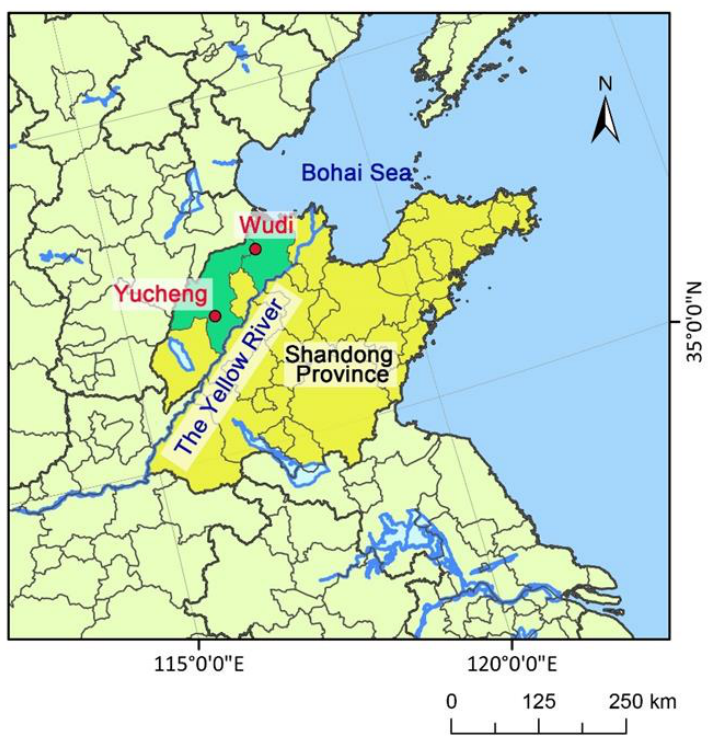
Figure 1. Locations of two experimental sites: Wudi and Yucheng. Table 1. The initial soil properties at 0–20 cm layer in the Yucheng (2008) and Wudi (2015).